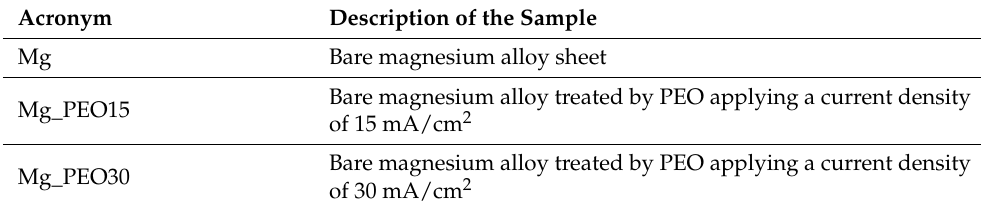
Table 2. Abbreviation used to identify the samples.